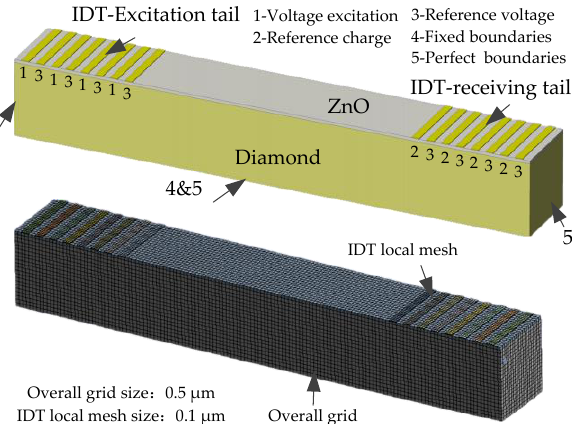
Figure 6. The geometric grid model and boundary conditions of the phonon piezoelectric device.